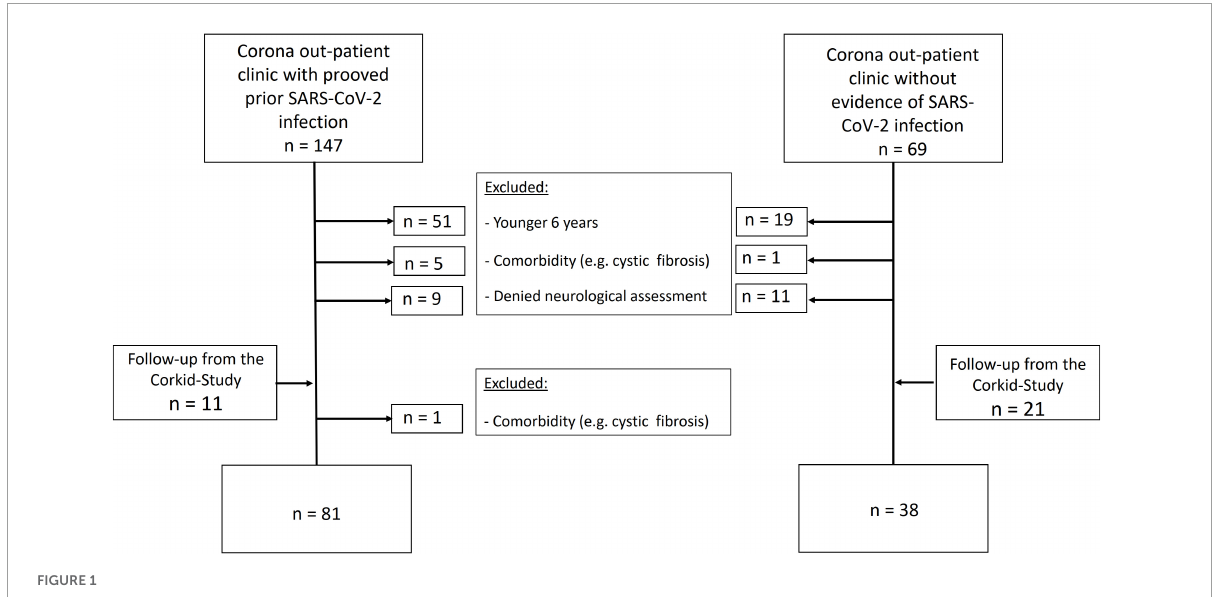
FIGURE1 STROBE flowchart of included